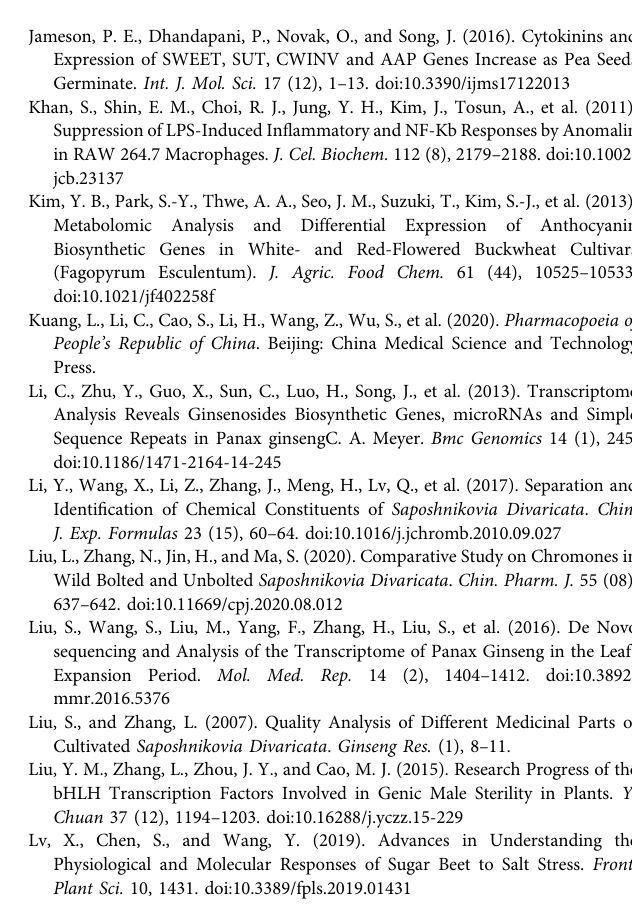
Supplementary Figure 1 | The length distribution and GC